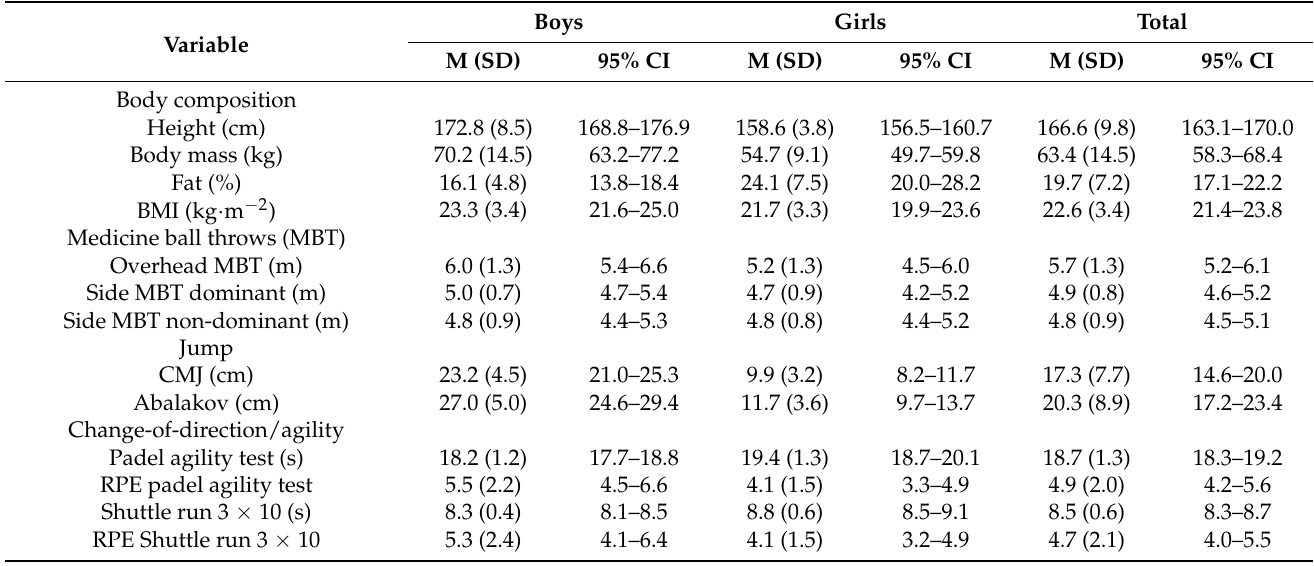
Table 1. Physical fitness and body composition values in boys ( n = 19) and girls ( n = 15) padel players aged 13 to 17 years